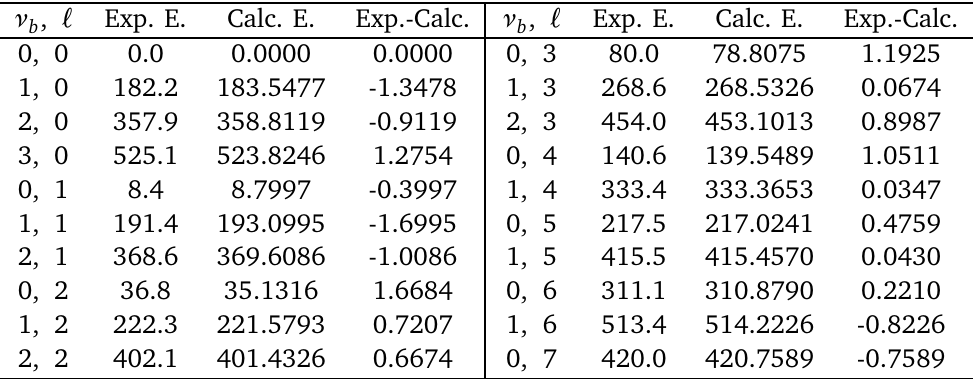
Table 2: Experimental [ 119 ] and calculated band origins and residuals for the CNC bending mode of CH NCO. Units of cm − 1 3